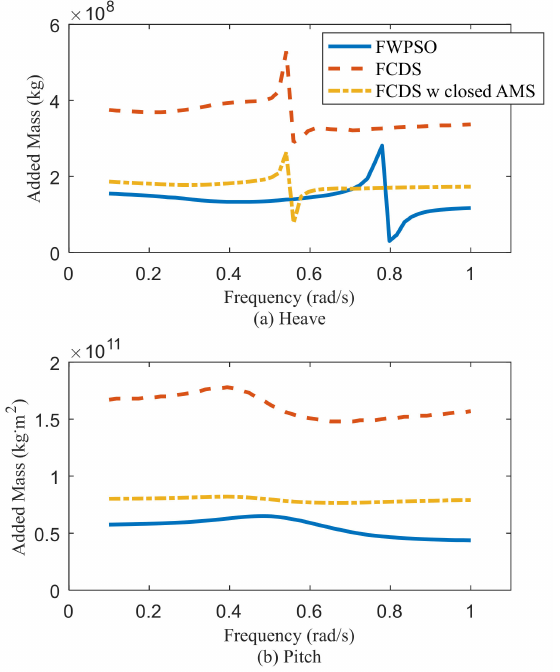
Figure 5. Added mass of the heave and